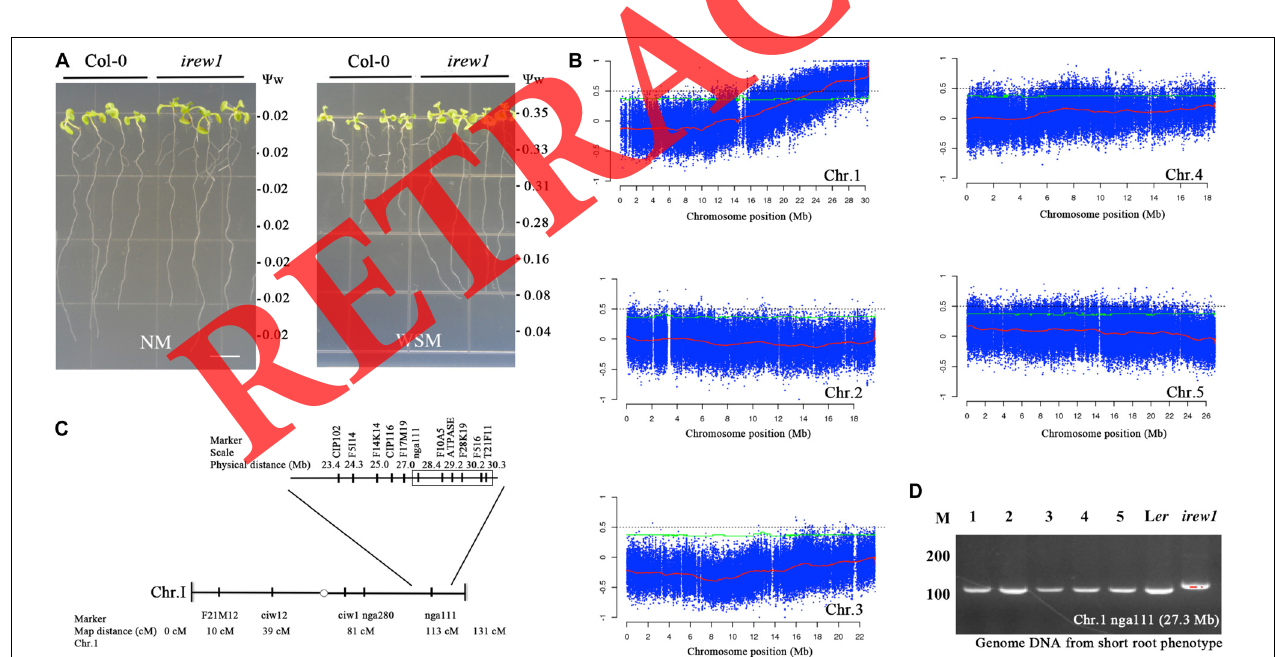
FIGURE 1 | Growth phenotype and map-based cloning of the Arabidopsis irew1 mutant. (A) Phenotype of 10 days after germination (dag) Col-0 and irew1 seedlings grown on a normal growth media (NM), and a water stress media (WSM). The water potentials ( (cid:57) w) on NM and WSM were measured and labeled. (B) SNP-index graphs of the Short Manhattan Plot. x -axis represents the position of five chromosomes; y -axis represents the SNP-index. Major (quantitative trait loci) QTL is located to chromosome 1. (C) Mapping of irew1 mutant. irew1 was mapped near the molecular marker nga111 on chromosome 1. The chromosomal number, markers used for fine-mapping, map distance (cM), physical distance (Mb) are shown. (D) PCR-SSLP analysis of a SNP present in nga111 (27.3 Mb) of Chr. We amplified from L er and irew1 (Col-0 background), and five recombinant plants (1–5) of the F 2 recessive (Short-root under WSM) phenotype population.